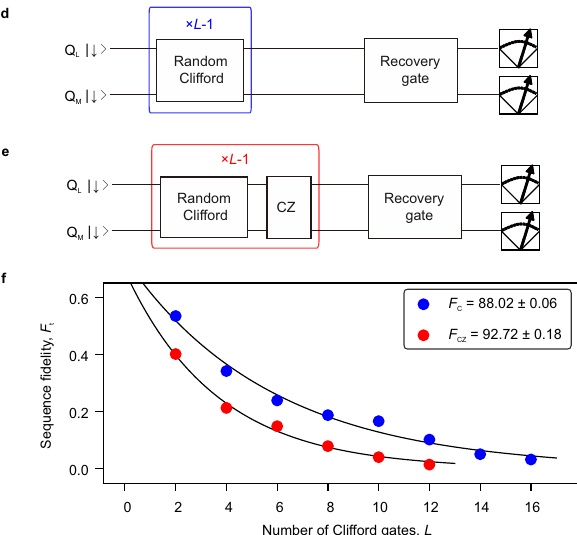
qubits to implement the DCZ gate (inside the dashed square) instead of X gates used in ( a ). The single-qubit phase gates are implemented by changing phases of the subsequent control pulses 1,12,37 . d , e Quantum circuit forthe two-qubitClifford- based randomized benchmarking measurement without ( d ) and with ( e ) inter- leaved CZ gates, respectively. The two-qubit Clifford group has11,520 elements all of which can be constructed from the combinations of CZ gates and single-qubit gatesactingonbothqubits 38,39 . f Thetwo-qubitCliffordgate fi delityandtheCZgate fi delity extracted by the randomized benchmarking measurement (Methods). The uncertainty in the gate fi delities is obtained by a Monte Carlo method 1,38